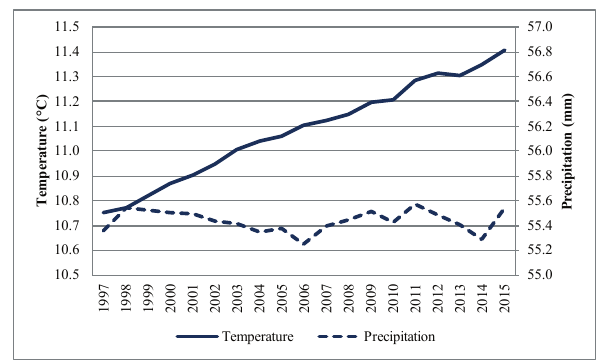
Figure 2. Median 30-years temperatures and precipitations in 1997- 2015. Source: elaboration on data from CRU of University of East Anglia. Note: data refer to the sample of 14 major producers of wine.